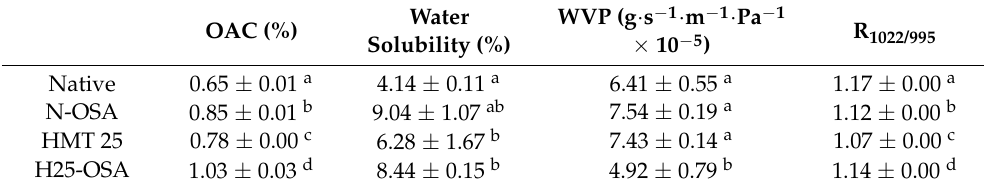
† Data are expressed as means ± SD. a–d : Mean values assigned with the same letters within a column are not significantly ( p < 0.05) different. N-OSA: native sago starch-OSA modification; HMT25: HMT sago starch treated 25% moisture treatment; H25-OSA: HMT 25-OSA